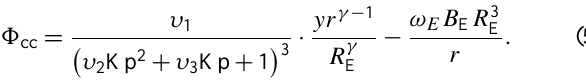
growth phase, whereas w j are fitting coefficients. In Fig. 3 we illustrate F B (t) for a substorm event with time stamps t i = 0 min, t g = 30 min, and t f = t r = 35 min, and five fitting parameters, w 1 = w 2 = 0, w 3 = 10, w 4 = − 15, and w 5 =